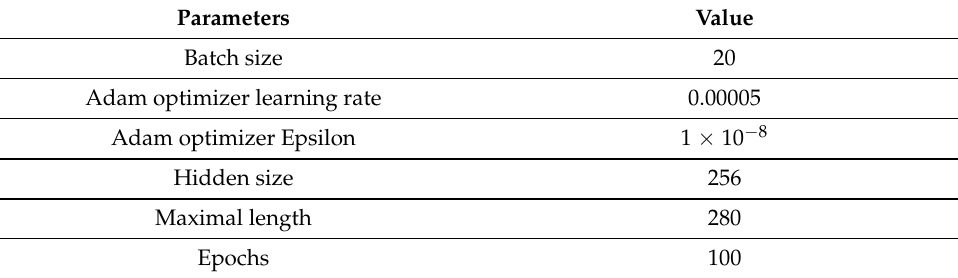
Table 3. Fine-tuned parameters of Arabic fake news detection mini-BERT